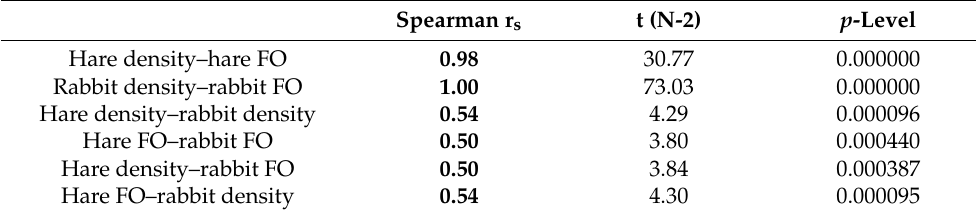
Table 1. Spearman’s rank-order correlations (in bold) between the temporal dynamics (December 2016 to December 2020), measured as mean monthly relative density and mean monthly frequency of occurrence (FO), of the Iberian hare ( Lepus granatensis ) and rabbit ( Oryctolagus cuniculus ) in a Mediterranean agricultural area in S. Spain ( n = 46). Intraspecific correlations between density and FO are included only to confirm both as alternative